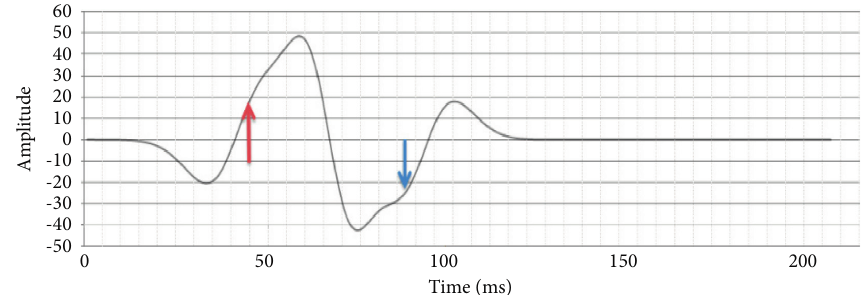
Figure 19: Synthetic seismic records obtained based on Figure